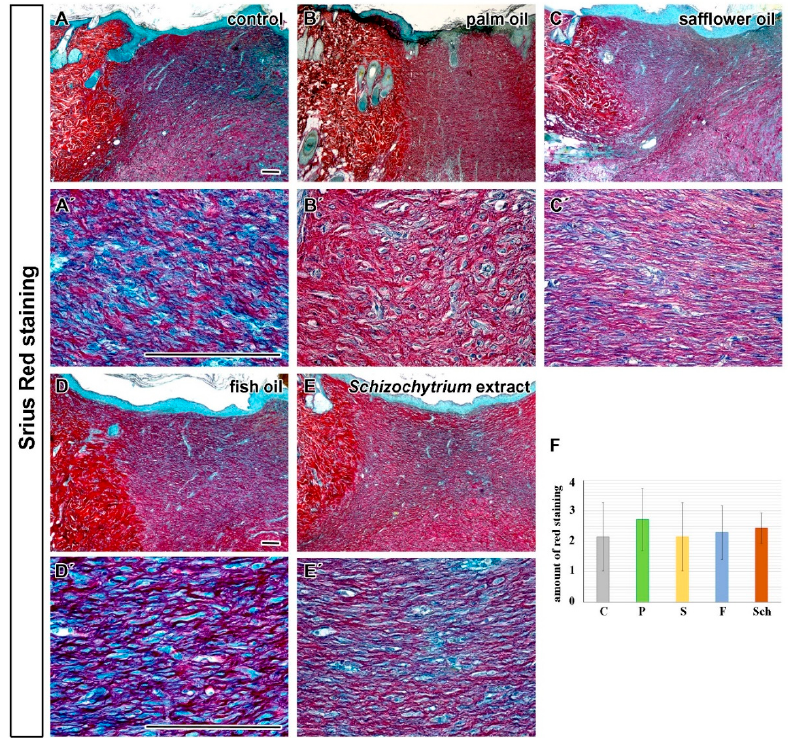
Figure 10. Sirius Red staining to visualize collagen maturation in dermis. ( A , A´ ): Transversal sections through skin at 12 days post-excision in the samples of the healing skin of rats fed by a standard diet alone (control, C); ( B , B´ ): a standard diet enriched with palm oil (P); ( C , C´ ): diet enriched with safflower oit (S); ( D , D´ ): diet enriched with fish oil (F); ( E , E´ ): diet enriched with Schizochytrium extract (Sch), respectively. ( F ): Quantification of Sirius Red staining. Intensity of staining was evaluated and “+” was labeled as the less mature collagenous tissues (intense purple/blue staining) and “++++” the most mature collagenous tissues (intense red staining), see Figure 14D–D’’’for the explanation of data analyses. Median values and standard deviations are displayed in the graph. Scale bar = 100 µm.